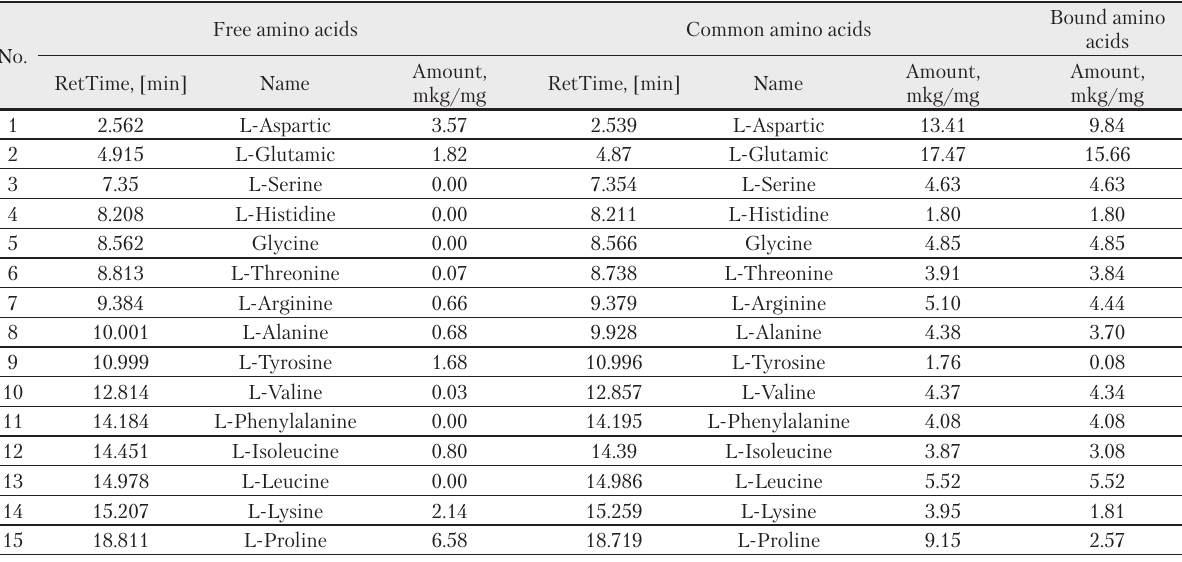
Fig. 1. HPLC-chromatogram, obtained at the determination of amino acids in Thalictrum foetidum L. herb Amino acid composition of Thalictrum foetidum L.